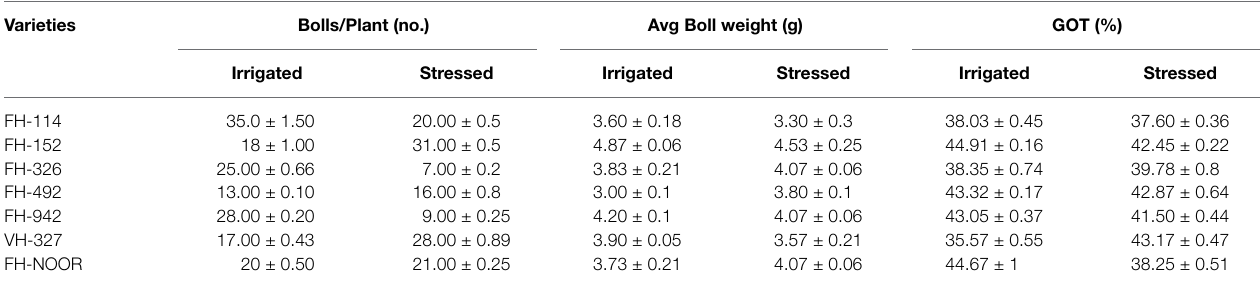
TABLE 4 | Consequences of drought stress on the yield parameters on cultivated varieties of cotton ( Gossypium hirsutum ). Varieties